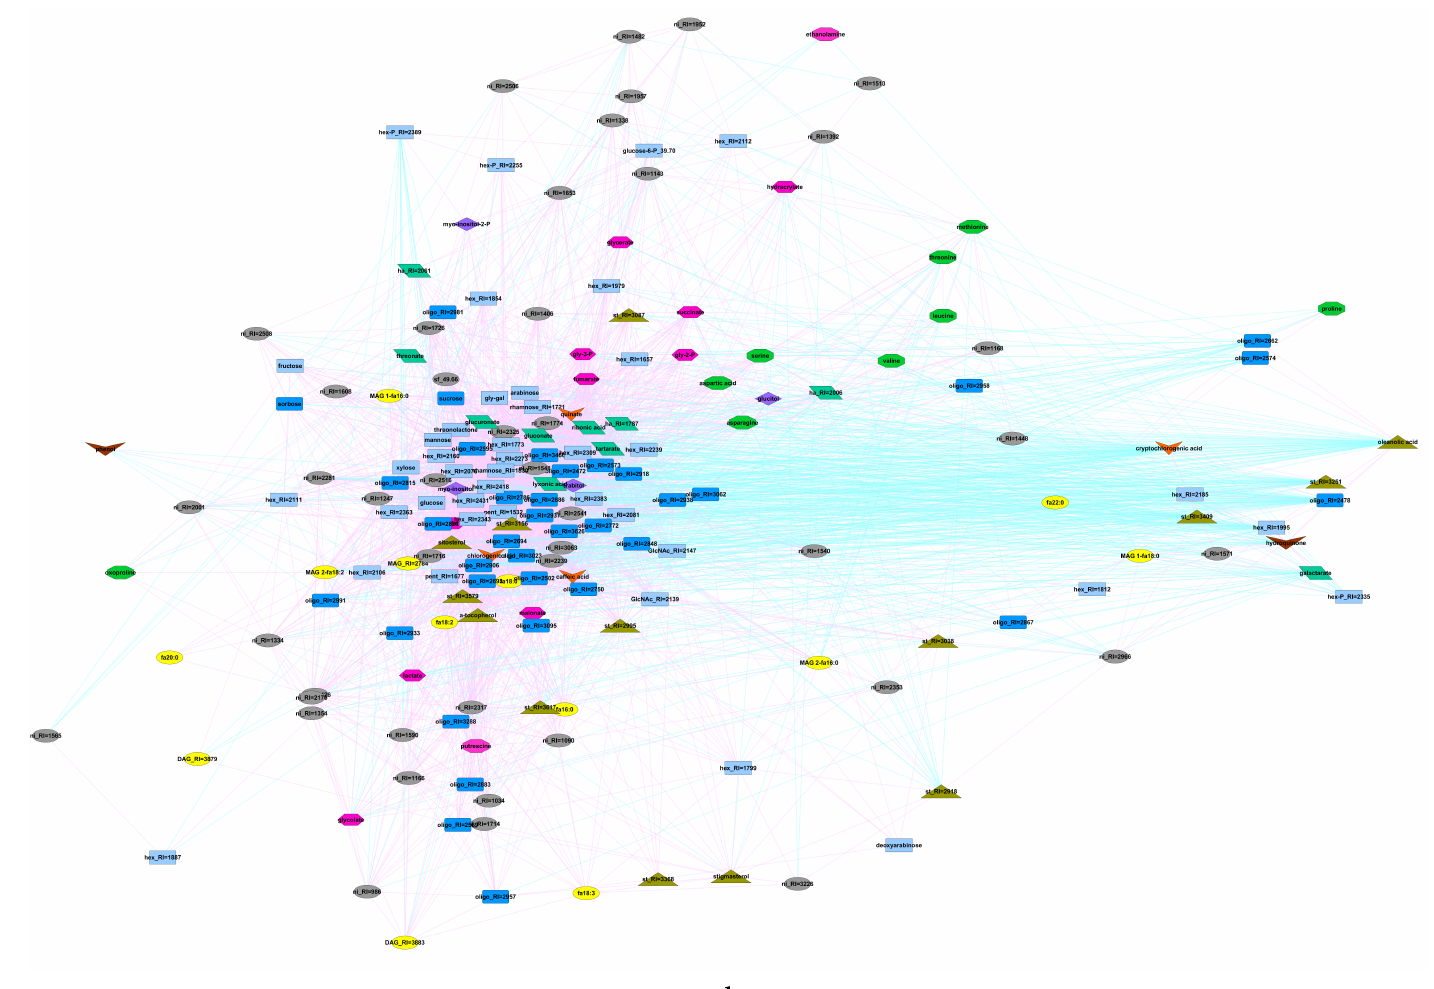
Figure 4. Metabolomic networks of anthers at the mature pollen stage of male-fertile ( a ) and male-sterile ( b ) genotypes. Yellow ovals–fatty acids and derivatives, blue rectangles–carbohydrates (bright–mono-, dark–oligosaccharides), green parallelograms–sugar acids, green octagons–amino acids, red hexagons–different small molecules, mainly carboxylates and other, olive triangles–sterols, brown concave quads–phenolic compounds, red concave quads–secondary metabolites, grey ovals–unidentified